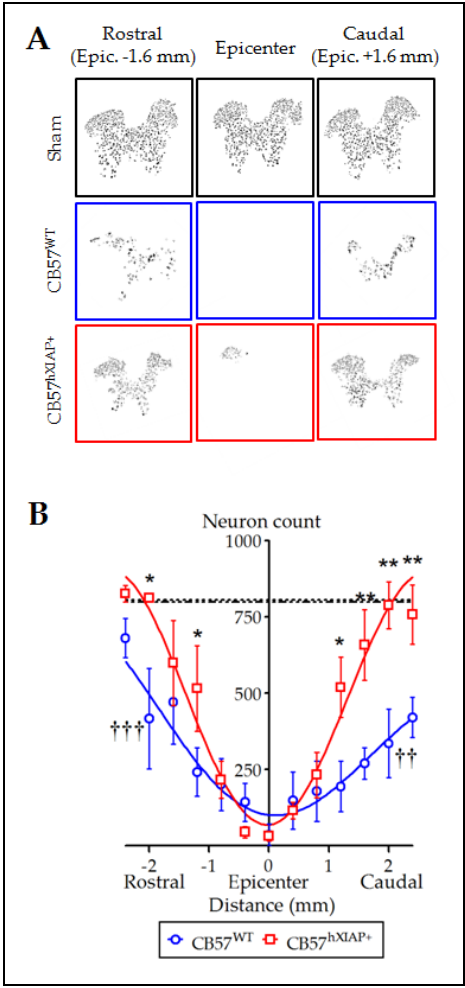
Figure 2. Overexpression of hXIAP reduces neuronal death after SCI. ( A ) Representative pictures obtained after processing of stained sections with TruAI integrated cellSens Dimensions software for neuron counting. ( B ) Estimations of the number of neurons in transverse sections comprising 4.8 mm surrounding the injury epicentre of the spinal cord show that CB57 hXIAP+ mouse sections (red symbols) have a significant increase in neuron counts with respect to CB57 WT mouse sections (blue symbols), particularly in sections caudal to the injury epicentre (symbols represent mean ± SEM and line the polynomial non-linear regression adjusts; * = p -value < 0.05 and ** = p -value < 0.01 for injured CB57 hXIAP+ vs. CB57 WT mice; in Student’s t -test; †† = p -value < 0.01 and ††† = p -value < 0.001 for injured CB57 WT mice vs. sham animals (dash-dotted line = sham CB57 WT ; dotted line = CB57 hXIAP+ ); n = 3-6 animals/group).